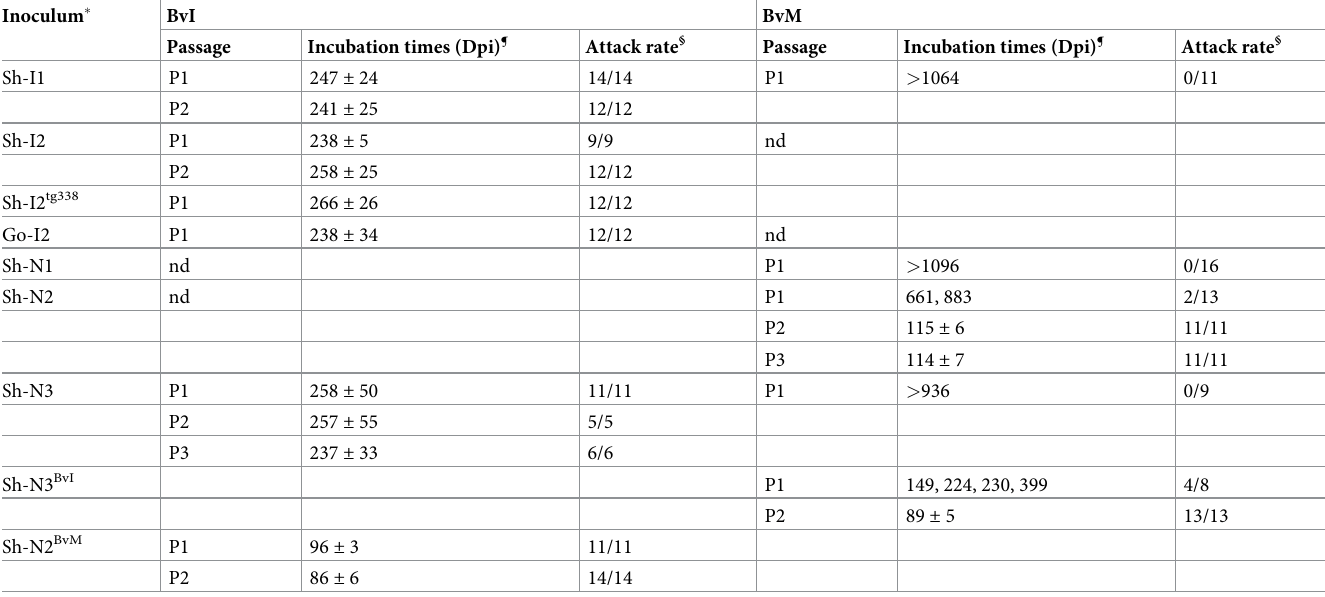
Table 3. Transmission of atypical scrapie isolates to BvI and BvM. Inoculum �